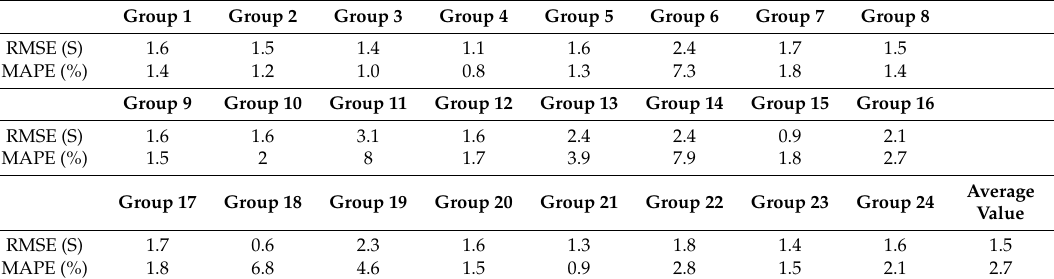
Table 5. Error evaluation during training phase for WordCount sample.